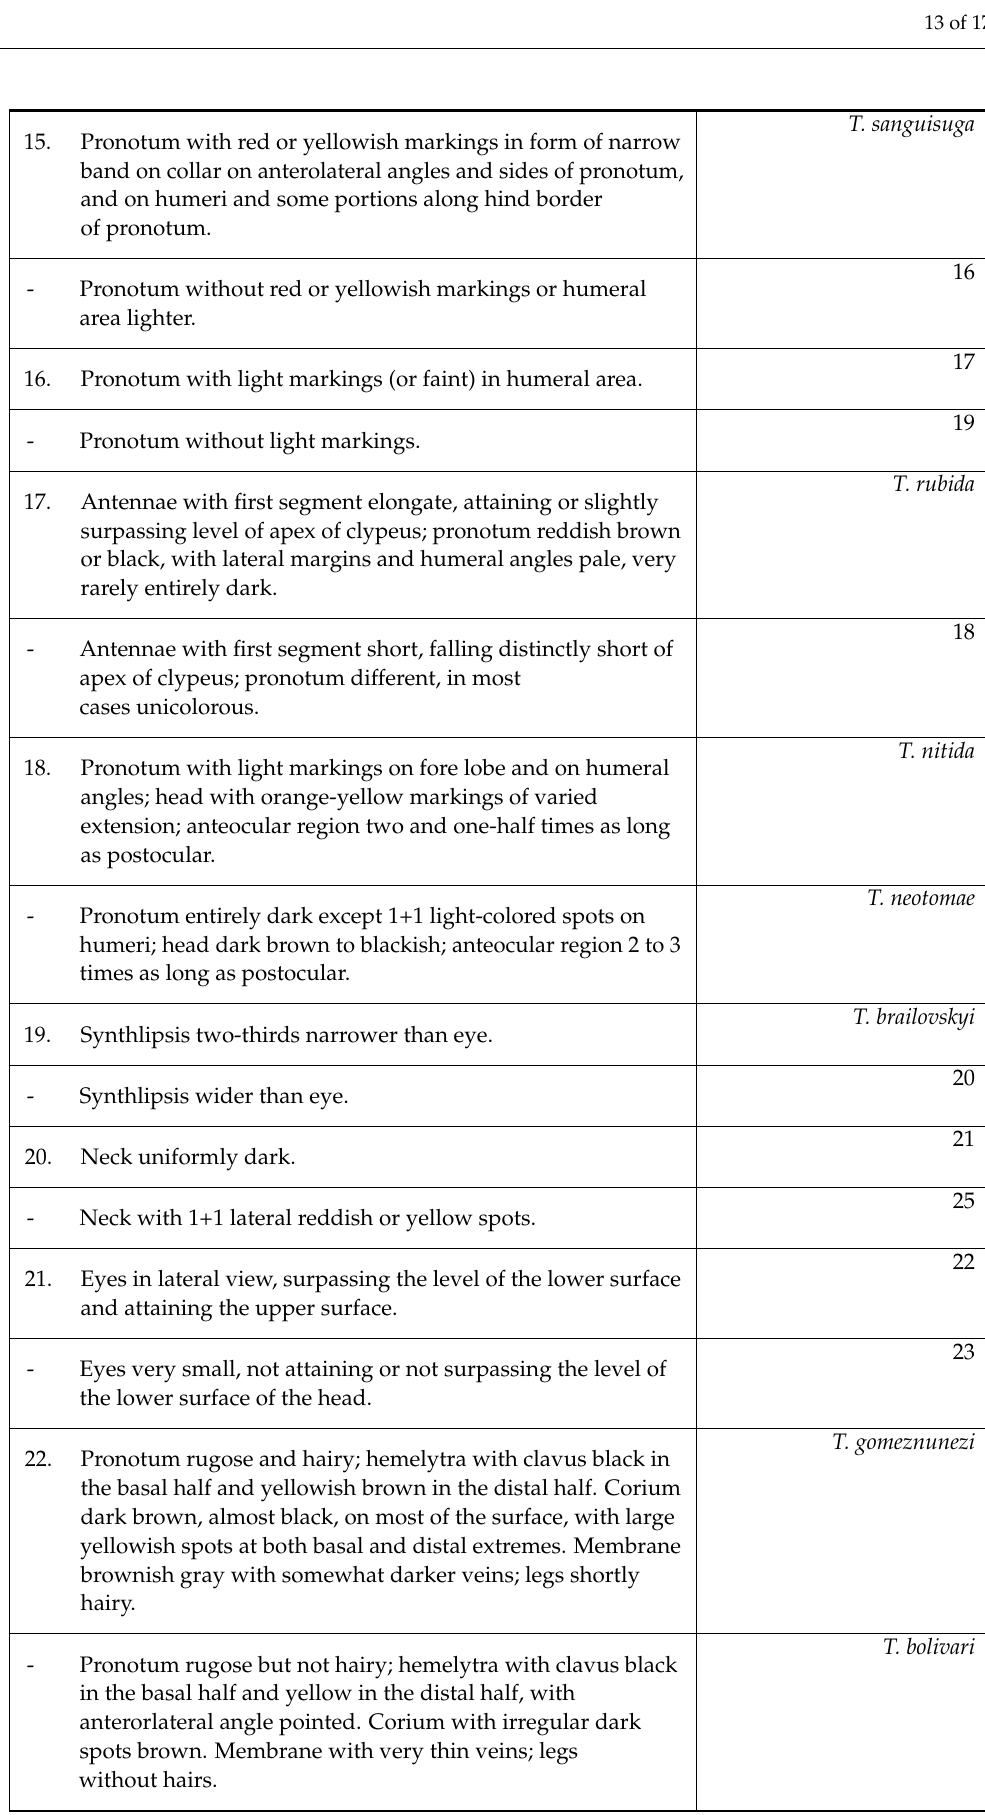
in the basal half and yellow in the distal half, with anterorlateral angle pointed. Corium with irregular dark spots brown. Membrane with very thin veins; legs without